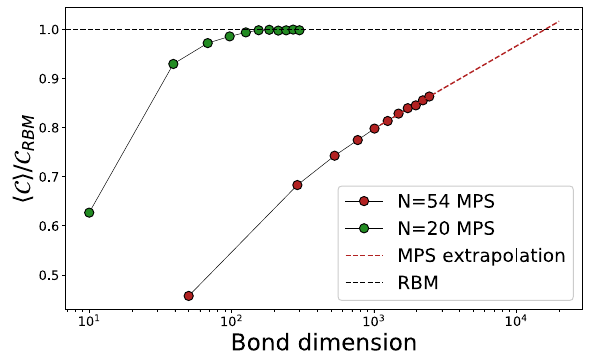
Fig. 5 Comparison with Matrix Product States. A range of MPS- based QAOA simulations are compared to our RBM ansatz performance on both 20-qubit and 54-qubit graphs at p = 2. In the 20-qubit case, we see quick convergence to the QAOA cost optimum with increasing bond dimension. Approximation ratio with of the RBM output is shown on the y -axis. However, on a 54-qubit graph, MPS accuracy increases approximately logarithmically with bond dimension. An approximation of the MPS bond dimension required for reaching RBM performance is extrapolated to be ≈ 1.5 × 10 4 which amounts to ~10 10 free